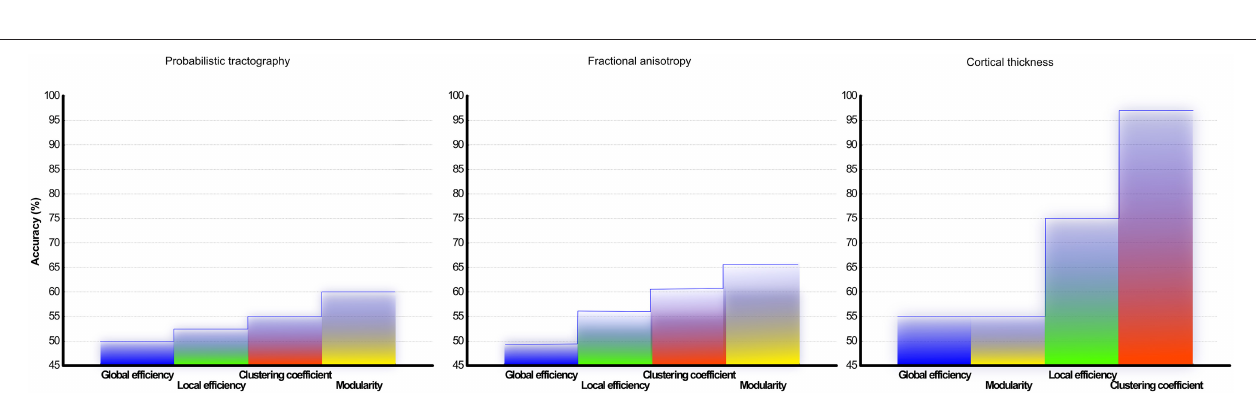
FIGURE 6 | Classification accuracy of CIS and RRMS: Results from the support vector machine analysis using classifier from network topology analyses measurements of (A) DTI and probabilistic tractography reconstruction of white matter and (B) fractional anisotropy (C) cortical thickness correlation matrix from gray matter. The overall classification accuracy in (%) is shown.